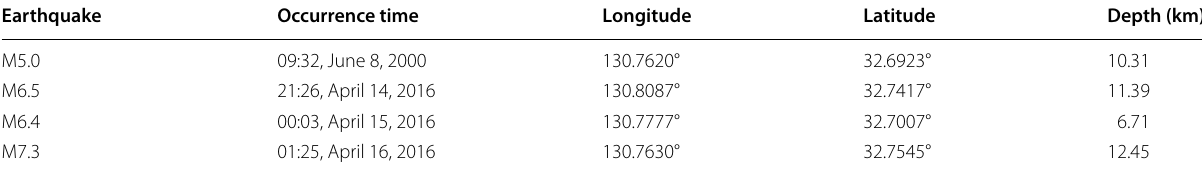
Table 4 The occurrence times and epicenter coordinates of the focal earthquakes Earthquake Occurrence time Longitude Latitude